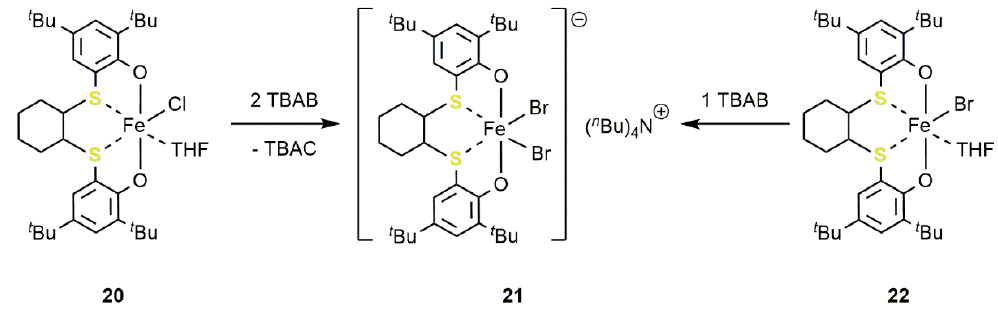
Figure 17. Synthesis of the ferrate species 21 from complexes 20 or 22 through reaction with two or one equivalents of TBAB, respectively [70].